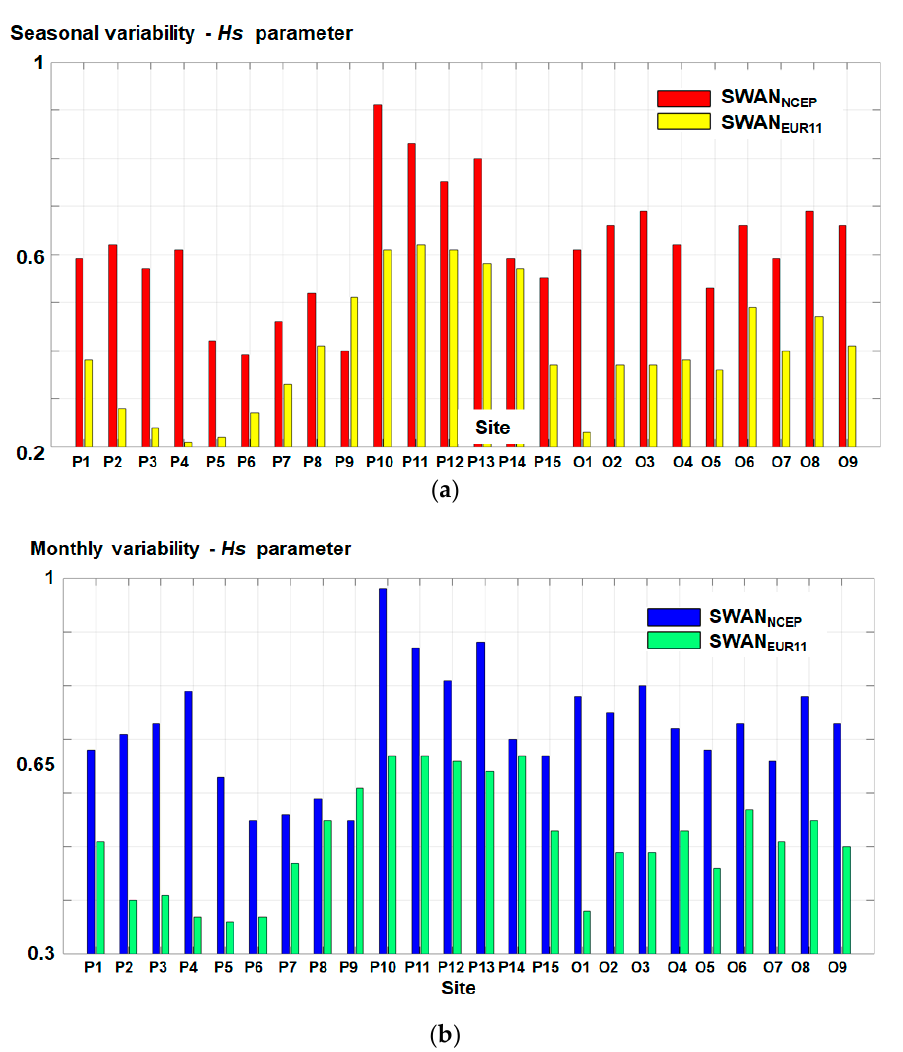
Figure 13. The variability of Hs simulated by SWAN NCEP and SWAN EUR11 computed in each site: ( a ) seasonal variability; and, ( b ) monthly variability.